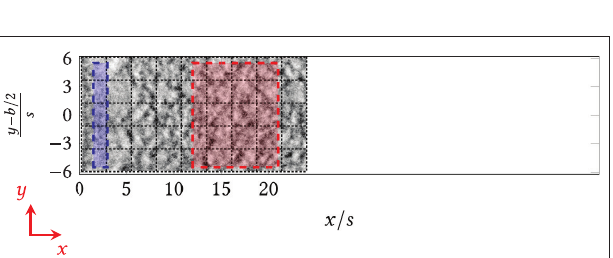
FIGURE 5 | Raster images of the area behind the step ( x = 0) taken at the confocal laser-scanning microscope, i.e., individual images were merged after the experiments (function tile merge ). Blue/red: Designated areas for the quantification of biomass and fluorescence. Blue: area directly behind the step; red: area downstream of the step/the reattachment zone.